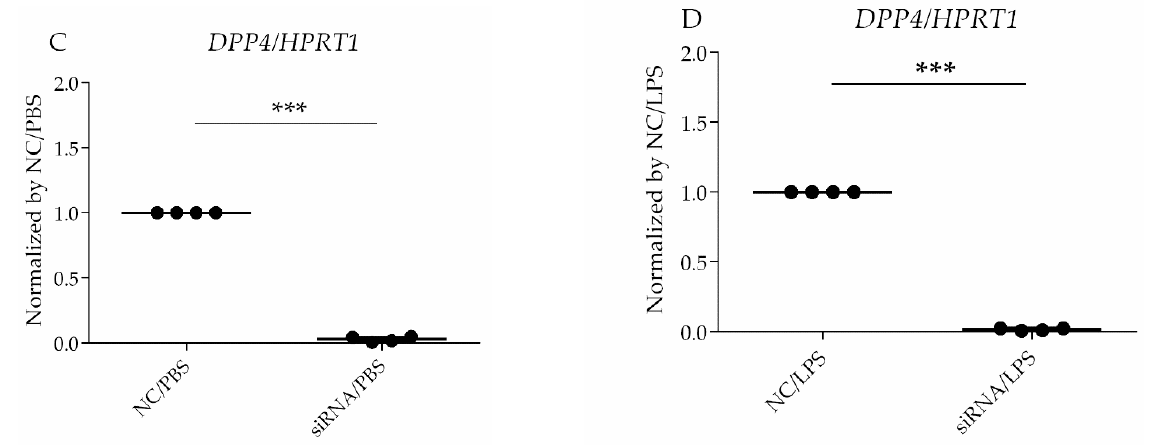
Figure 1. Validation of CD26/DPP4 expression levels in HLMVECs treated with siRNA. HLMVECs were transfected with non-specific (NC) or DPP4 -specific siRNA for 72 h, and then challenged with LPS (1 µ g/mL) or PBS for 18 h. ( A ) CD26/DPP4 expression levels in cultured HLMVECs after vehicle or siRNA treatment followed by PBS challenge (measured by mean fluorescent intensity (MFI) using flow cytometry analysis); ( B ) CD26/DPP4 expression levels in cultured HLMVECs after siRNA treatment followed by LPS or PBS challenge (measured by MFI using flow cytometry analysis); ( C ) mRNA expression levels of DPP4 relative to those of the control mRNA HPRT1 in HLMVECs after siRNA treatment followed by PBS treatment as the baseline condition (measured by quantitative PCR); and ( D ) mRNA expression levels of DPP4 relative to those of the control mRNA HPRT1 in HLMVECs after siRNA treatment followed by LPS treatment (measured by quantitative PCR). *** p < 0.01. Values are means ± SD of three independent experiments. N.S., Not significant; Veh., Vehicle; and NC, Non-specific control RNA.